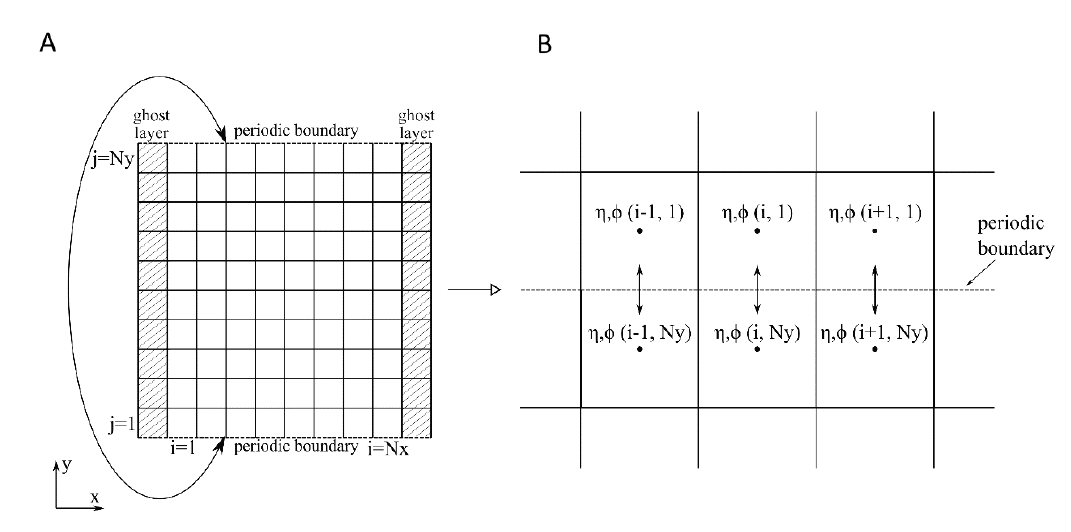
Figure 2. MILDwave periodic boundaries implementation by [32]. ( A ) The information reaching one end of the domain enters the opposite end. ( B ) Equations (1) and (2) are solved as if the boundaries were next to each other. Figure adopted from